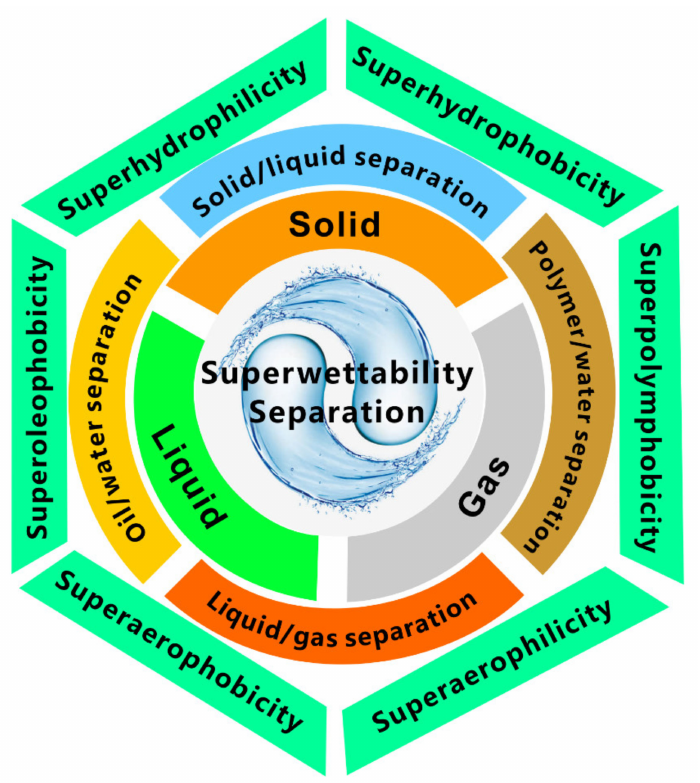
Figure 1. Solid/liquid/gas separation based on the surface superwettability.